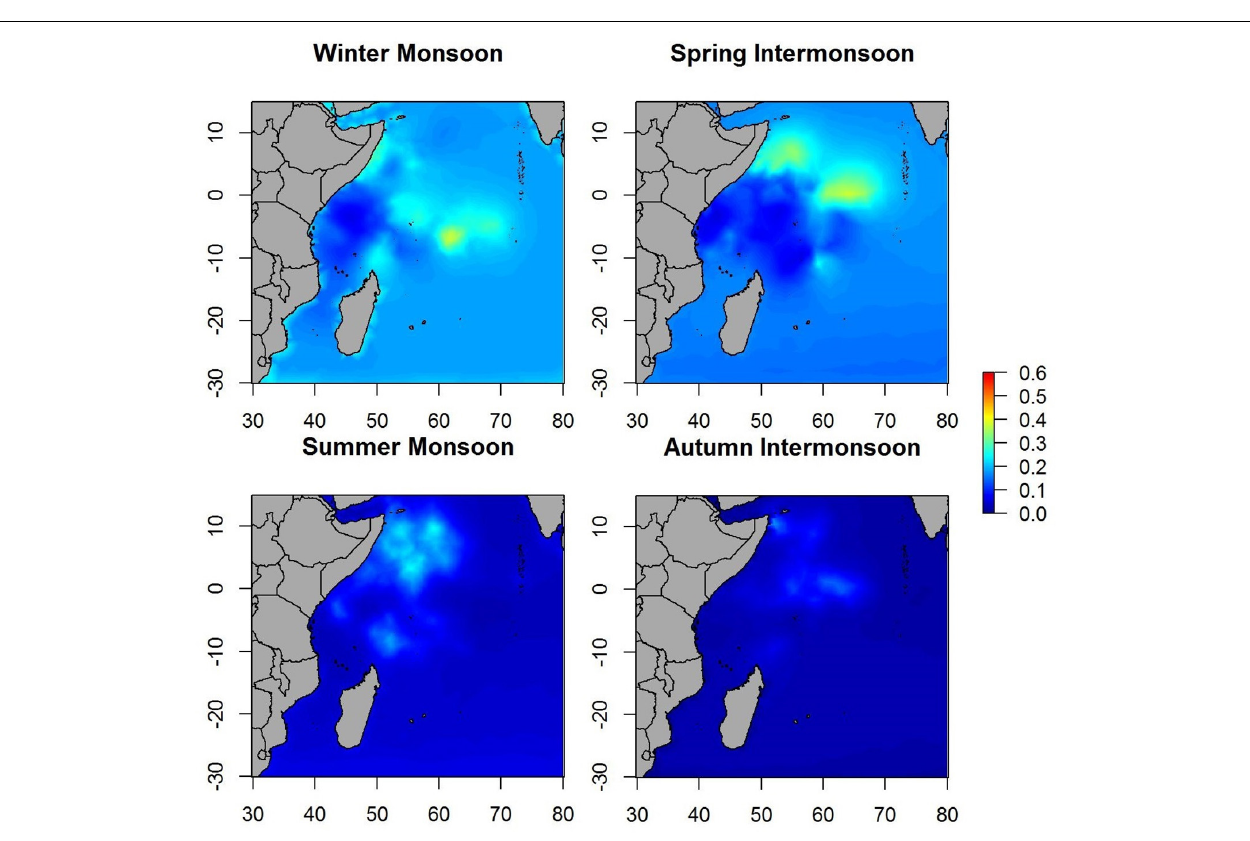
FIGURE 6 | Maps of the posterior mean of non-tuna occurrence probability in different